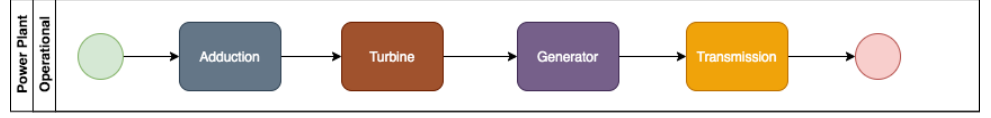
Figure 2. Macro view of the system with 4 subsystems.